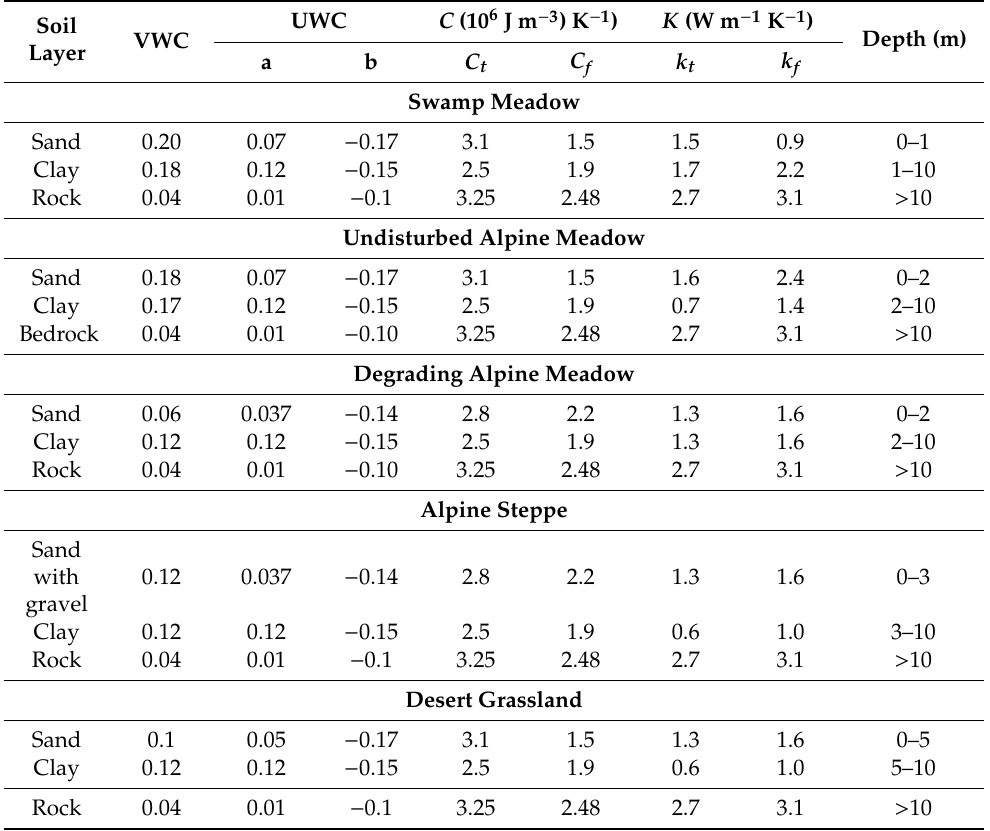
Table 2. Parameter values used in ground temperature simulations in each ecotype for each